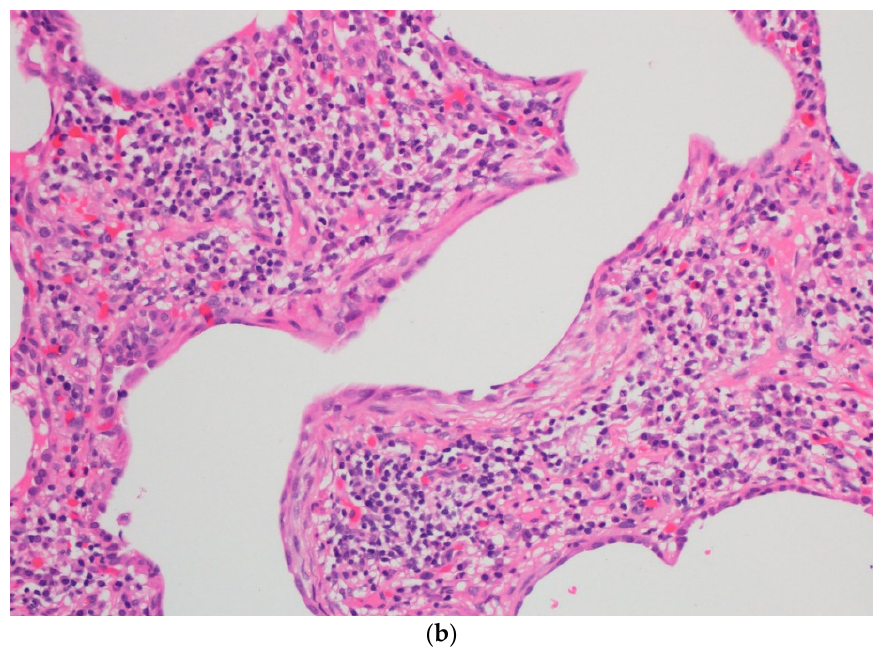
Figure 3. Sections show wedge lung biopsy characterized by patchy inflammatory process. The inflammation is bronchiolocentric ( a ) with significant extension into the interstitium consisting of sheets of lymphocytes, plasma cells, foamy macrophages, and rare eosinophils as well as neutrophils ( b ). No definitive granulomas, desquamation, vasculitis, significant eosinophilic infiltrate, Langerhans’ cells, or fibrosis are seen. Special stains for fungi, acid-fast organisms, and viral inclusions are negative.